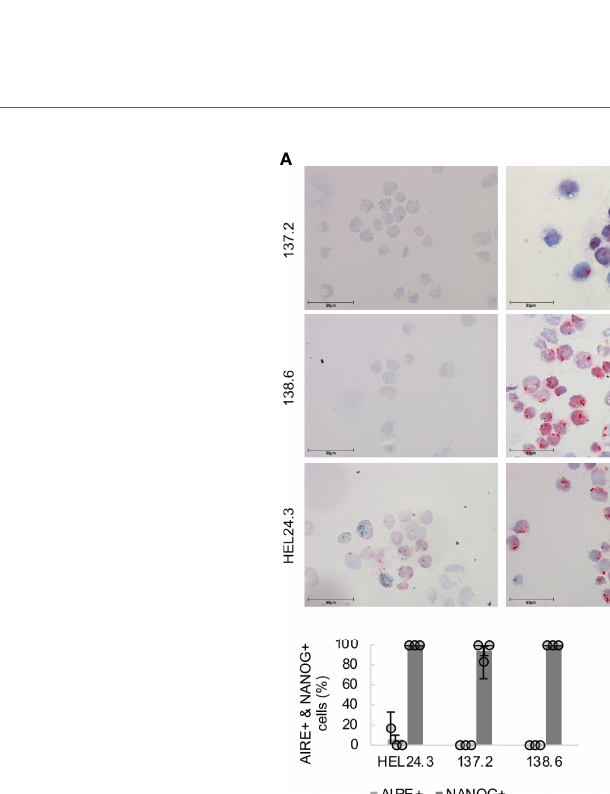
FIGURE 2 | Expression of AIRE and stemness-associated genes does not differ in APECED patient -derived iPSCs compared to healthy person-derived iPS cells. The relative mRNA expression of AIRE and common stem cell associated markers in APECED iPSCs (137.2 & 138.6) and a healthy control (HEL24.3) iPSCs. Expression levels presented as a mean of DD Ct fold change (columns) of three independently analyzed biological replicates (shown as circles), normalized to HEL24.3. Error bars of circles represent SD within a replicate. Error bars of columns represent SEM of the three replicates. No statistically signi fi cant difference was observed between the cell lines (p > 0.05).